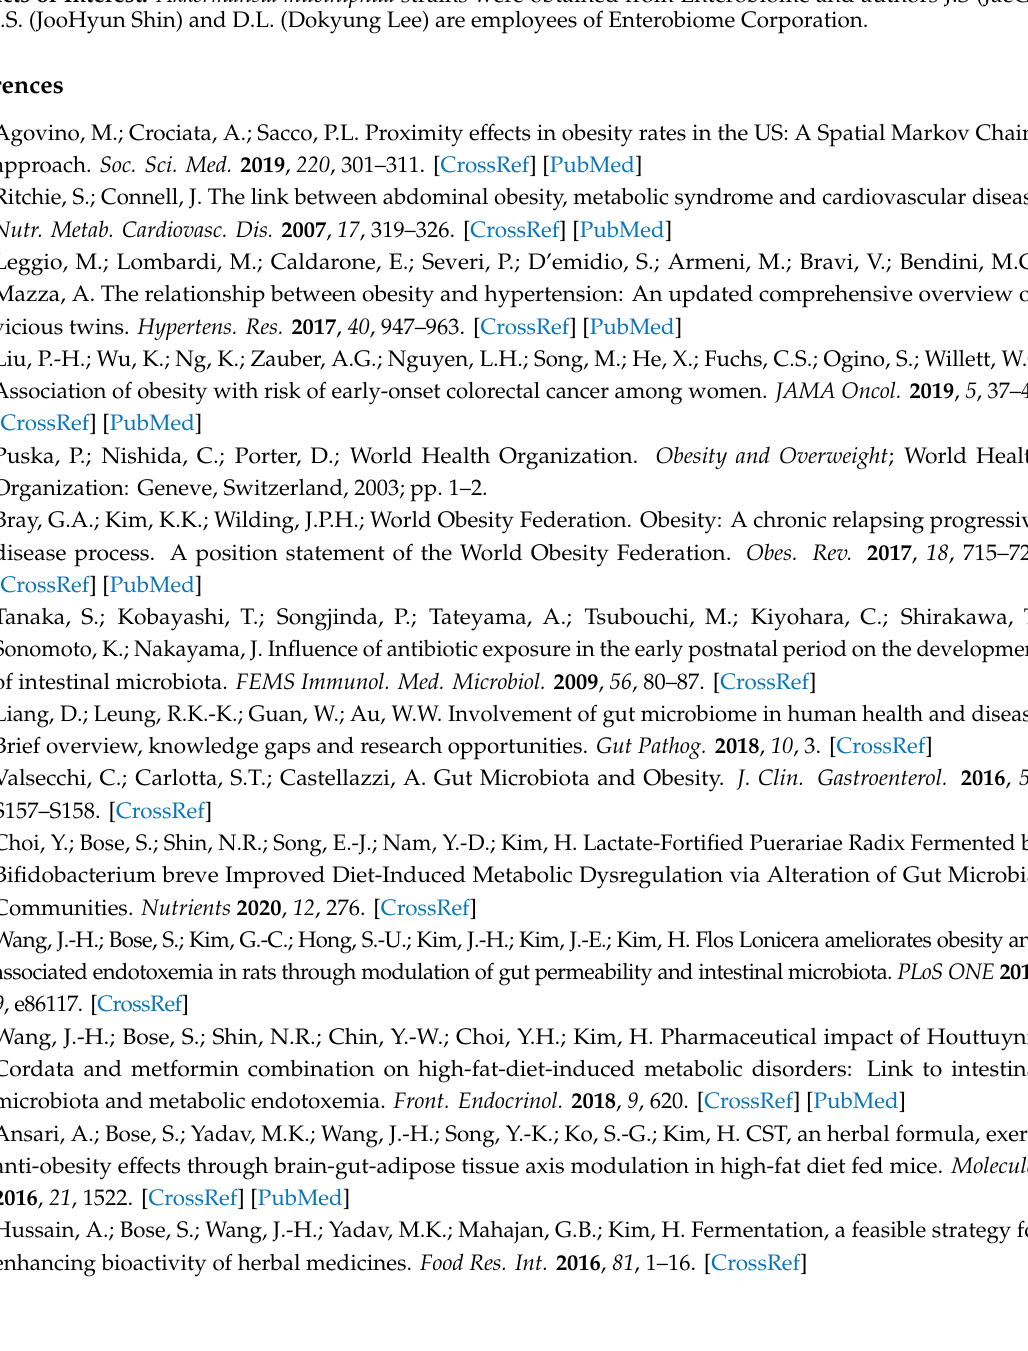
Figure S1: Genetic diversity of A. muciniphila strains. Figure S2: A. muciniphila strains improved glucose homeostasis in HFD-induced obese mice. Figure S3: A. muciniphila strains mitigate liver injury. Figure S4: A. muciniphila treatment modulated the composition of the gut microbiota. Table S1: Information on the fecal sample from healthy volunteers. Table S2: Primer sequences for PCR. Table S3: E ff ect of A. muciniphila on adiposity, liver weight, and energy e ffi ciency in mice. Table S4: Modulation of gut microbiota composition by the treatment of A. muciniphila